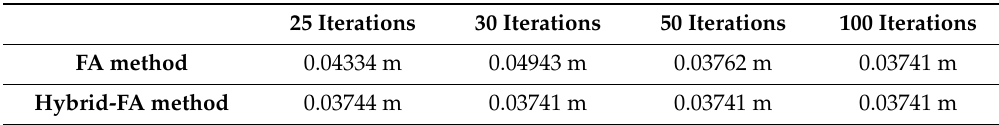
Table 1. The root-mean-square error (RMSE) of the hybrid-FA and FA methods with different numbers of iterations.